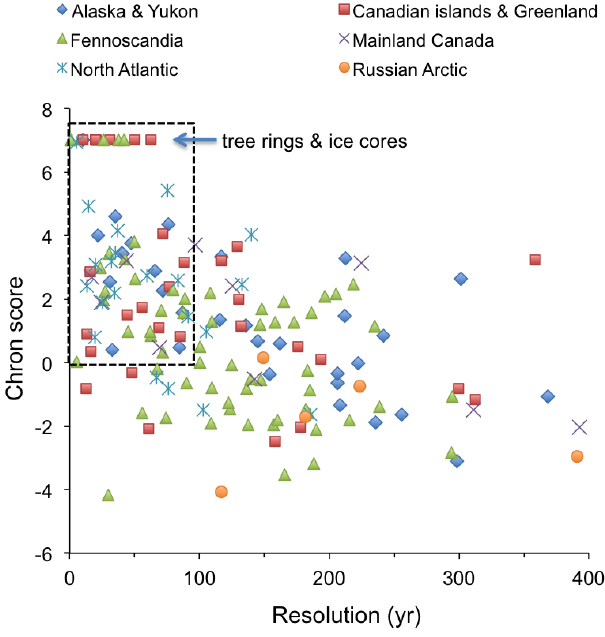
Figure 3. Geochronology accuracy score (chron score) versus sam- pling resolution for records in the database. Records from trees and glacier ice are arbitrarily assigned a chron score of 7. Highly re- solved records (better than 100 years on average) with high chron scores ( > 0) are enclosed by the square and their location is plotted in Fig.